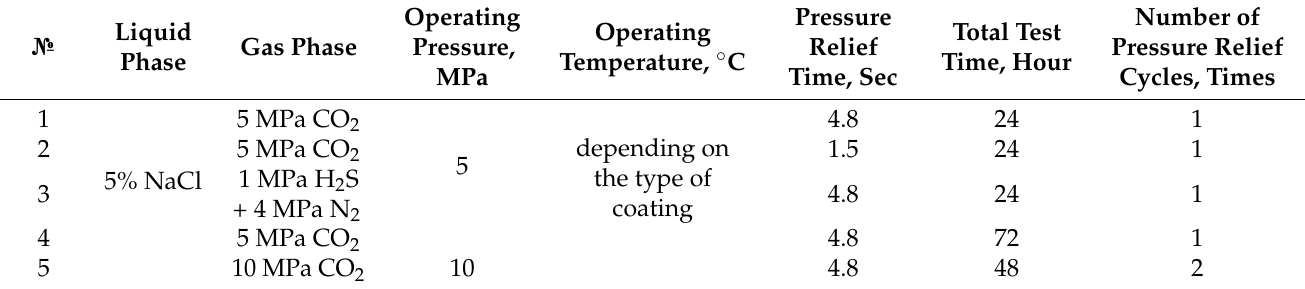
Table 1. Testing conditions of autoclave decompression